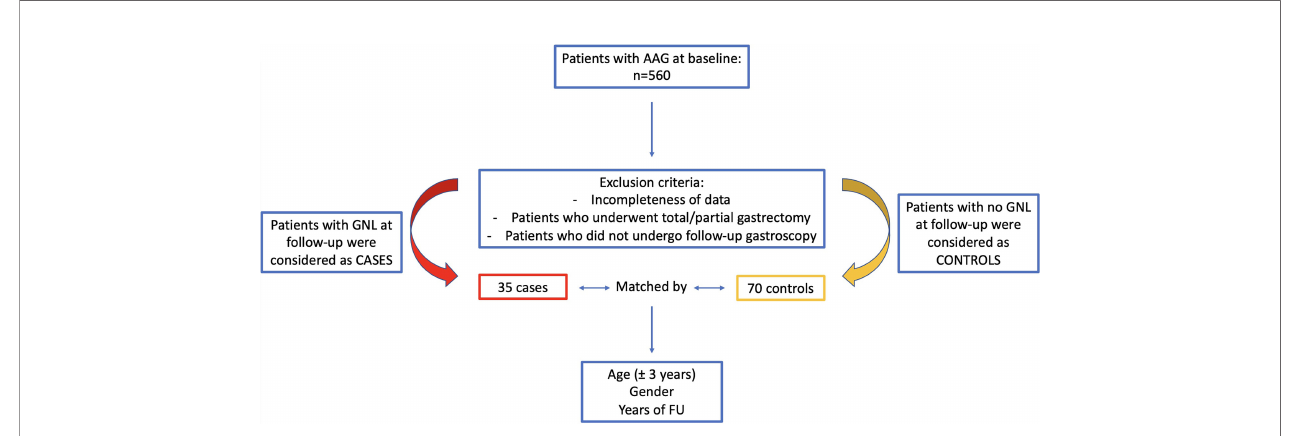
FIGURE 1 | Flowchart of the study population of patients with autoimmune atrophic gastritis included in the case –